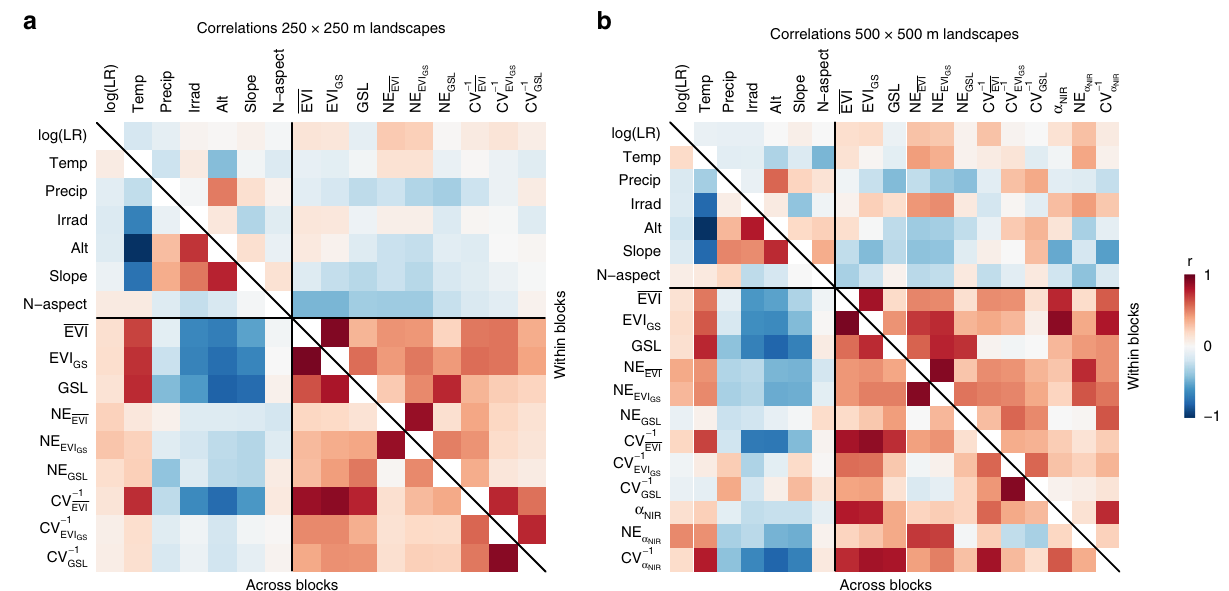
EVIN−aspectSlopeAltIrradPrecipTemplog(LR) Fig. 5 Correlations among landscape richness, environmental co-variables, and landscape functioning variables for 250 × 250 m and 500 × 500 m landscape plots. Matrices show overall (across block) and block-adjusted (within block) Pearson correlation coef fi cients ( r ) for 250 × 250 m landscapes ( a ) and 500 × 500 m landscapes ( b ). Adjusting for block reduces correlations of landscape richness and environmental variables (all n.s.). log(LR): log- transformed landscape richness; Temp: mean annual temperature; Precip: annual precipitation; Irrad: mean irradiation; Alt: altitude; Slope: slope; N-aspect: north-south aspect; EVI and EVI GS : mean and integrated growing-season productivity; GSL: growing-season length; α NIR : near-infrared albedo; NE: net diversity effect for these variables; CV − 1 : temporal stability of these variables; n = 237 and 77 for 250× 250 m and 500 × 500 m land-cover composition × block combinations, respectively. Source data are provided as a Source Data fi φ + α ω + φ + β ]. As speci fi ed by the HANTS algorithm, observed data 2 ) 3 cos(4 3 ) with residuals exceeding speci fi c thresholds (0.5, 0.2, 0.1 and 0.05 raw EVI values)